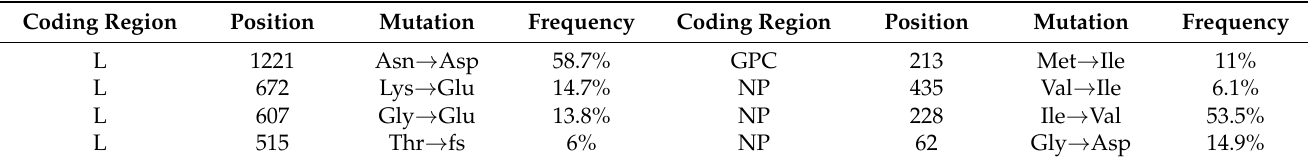
Table 1. Summary of